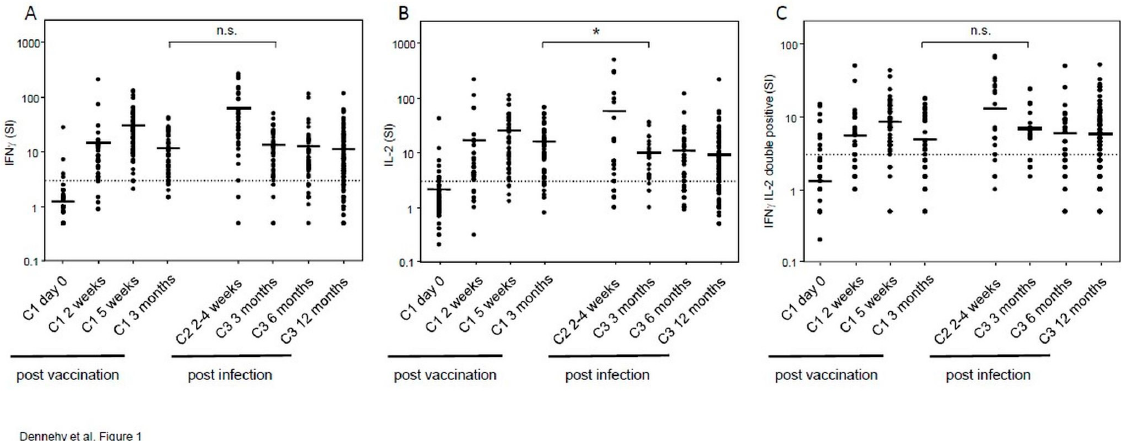
Figure 1. Comparison of cells producing IFN γ ( A ), IL-2 ( B ), or both IFN γ and IL-2 ( C ) measured as stimulation index by ELISpot after stimulation with SARS-CoV-2 antigens at different time points following vaccination (cohort 1) or infection (cohorts 2 and 3). Horizontal bars indicate mean values. The dotted line shows the lower cut-off of SI = 3, below which all results are negative. * indicates significant differences with p < 0.05, n.s. indicates non-significant differences.